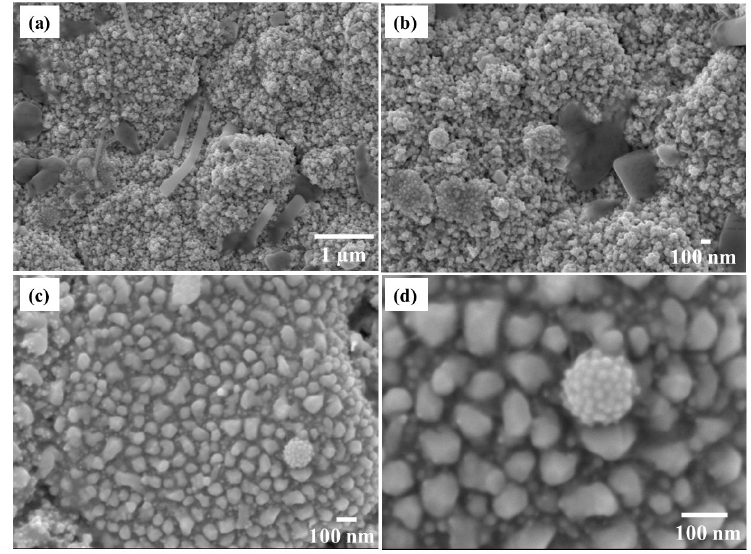
Figure 5. FESEM images of the sample deposited at RT with different magnifications ( a ) ×20,000 ( b ) ×30,000 ( c ) ×60,000 ( d ) ×150,000, as pointed out on the scale bars.